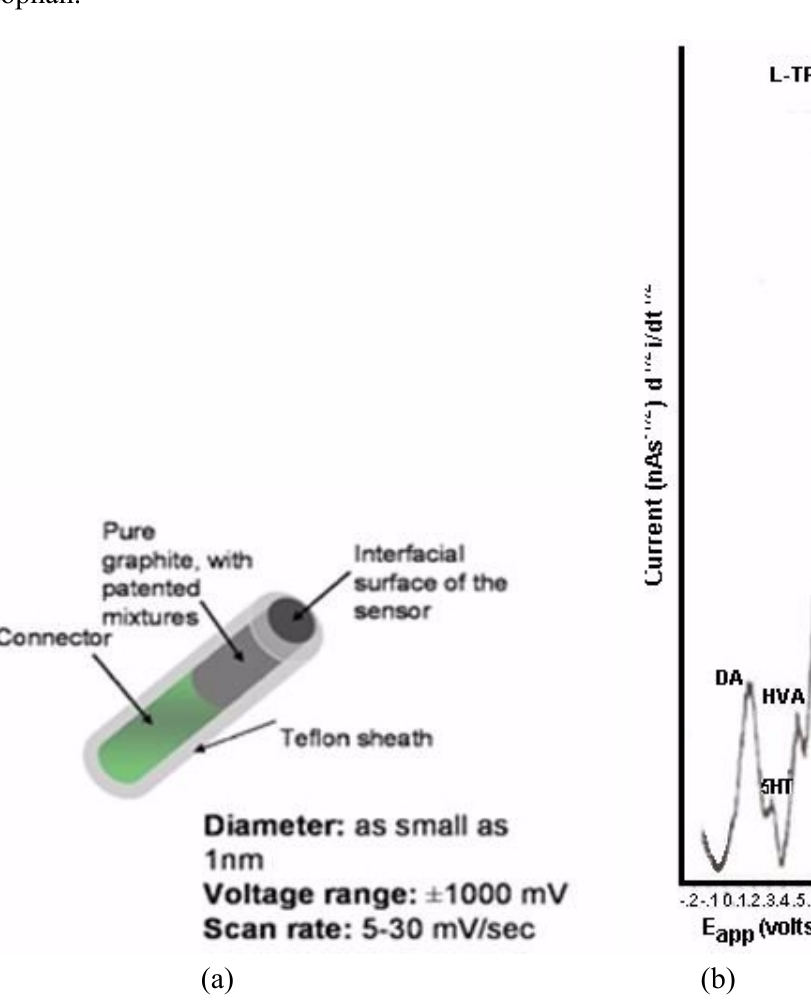
Figure 1. ( a ) BRODERICK PROBE ® ( b ) Typical baseline signatures for NMI recording of neurotransmitters (NT) in dorsal striatum (DStr); x axis is potential in millivolts, y axis is current as defined by the semiderivative reduction circuit, discovered in this laboratory (52). Symbols: DA is dopamine, 5-HT is serotonin, HVA is homovanillic acid and L-TP is